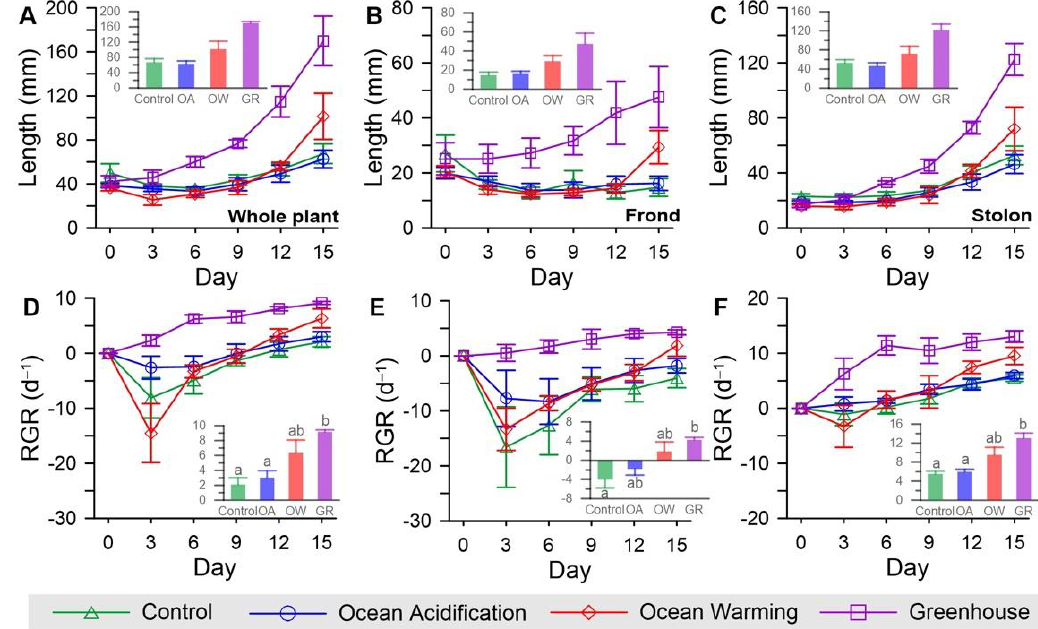
Figure 3. Thalli length ( A – C ) and relative growth rates (RGR, ( D – F )) of whole plant ( A , D ), frond ( B , E ), and stolon ( C , F ) for C. sertularioides under present and three simulated future ocean conditions. Bar graphs represent the thalli lengths and RGR on the 15 days of the experiment. The different letters indicate significant differences between treatments based on Tukey’s HSD post -hoc comparison ( p < 0.05). Data are represented as mean ± SE (n = 4).